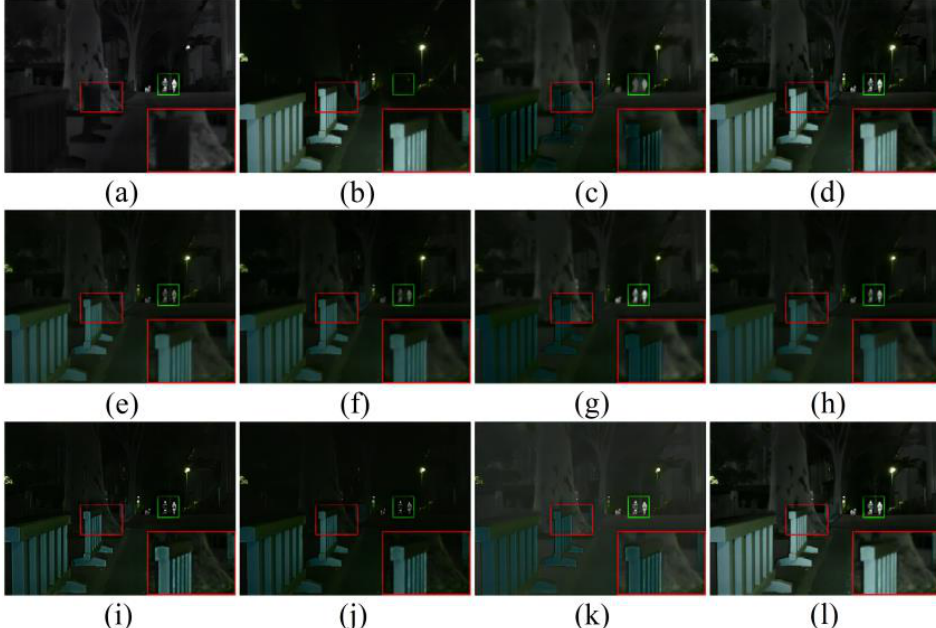
Figure 11. Comparison of 10 image fusion methods in a night scene. ( a ) Infrared. ( b ) Visible. ( c ) GTF. ( d ) MST-SR. ( e ) DenseFuse. ( f ) RFN-Nest. ( g ) FusionGAN. ( h ) GANMcC ( i ) IFCNN. ( j ) U2Fusion. ( k )SDNet. ( l ) SeAFusion. The green area is to highlight the fusion effect, while the red area is to highlight the fusion effect in the details.